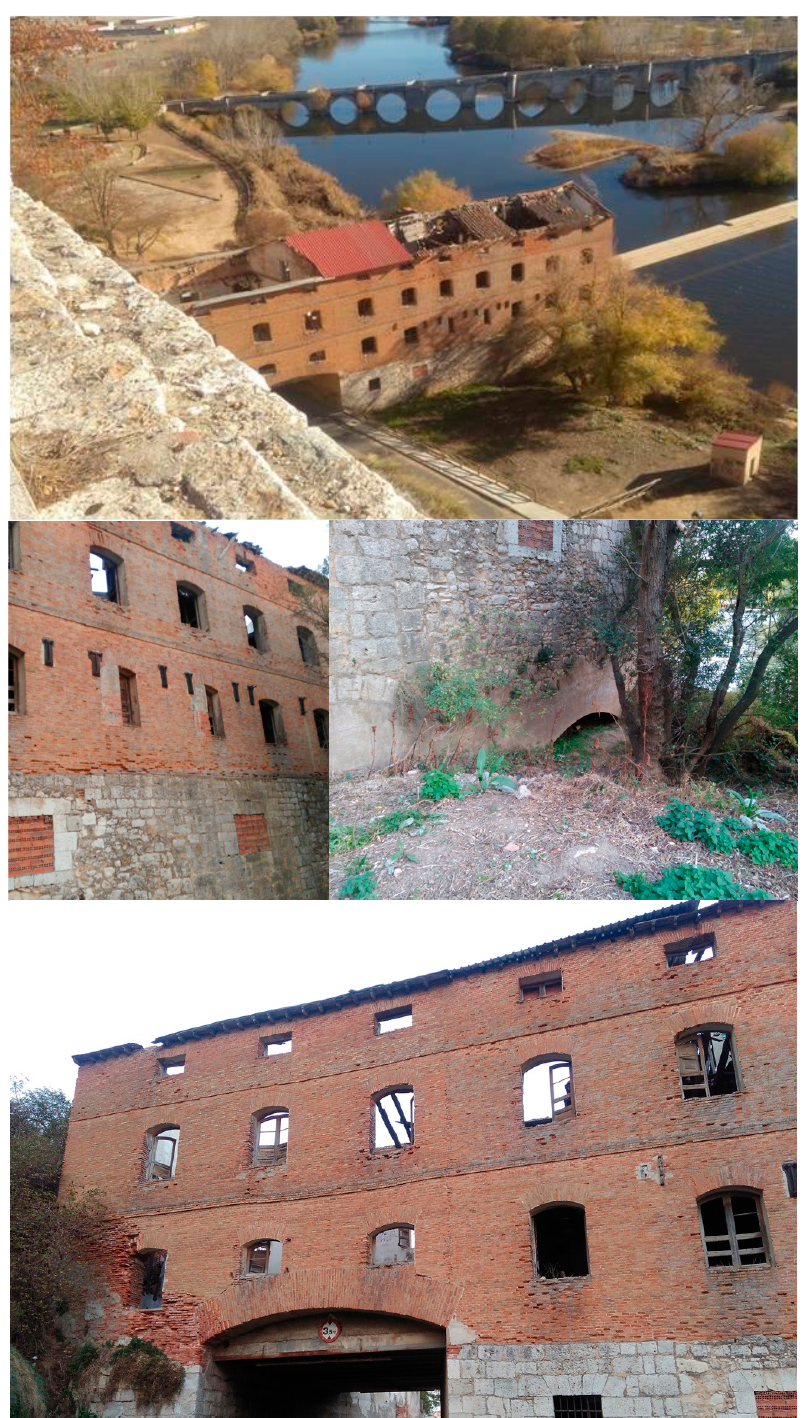
Figure 3. Photographs of the factory, 2019.